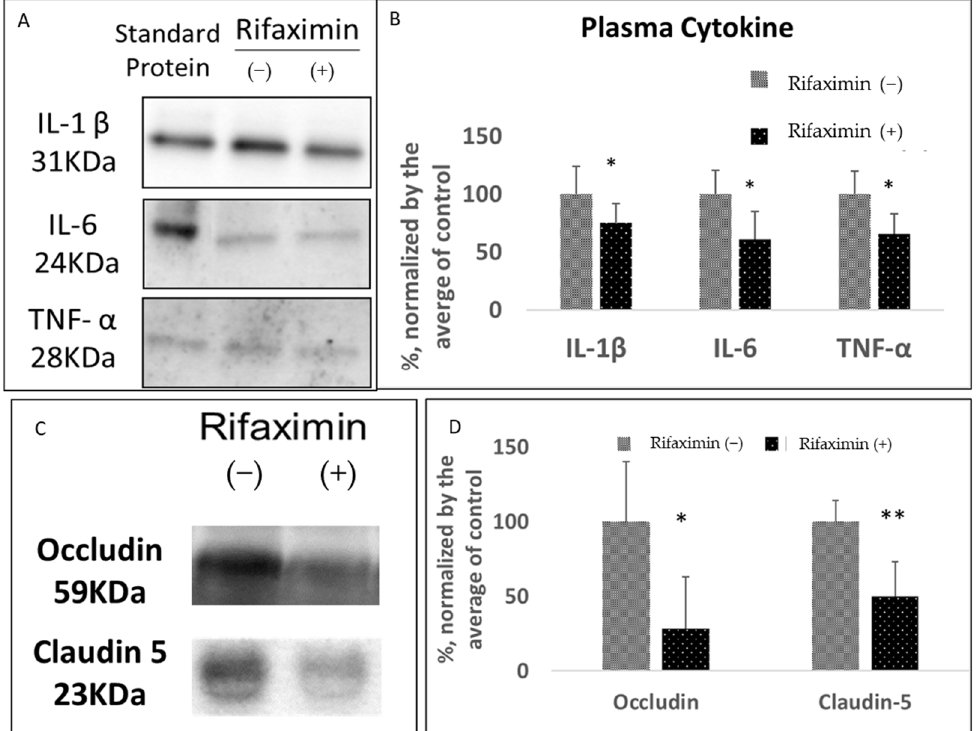
Figure 2. Effect of rifaximin treatment on the serum markers of inflammation and the blood–brain barrier in MitoPark mice. The serum samples of the MitoPark mice that were or were not treated with rifaximin for 3 months were obtained after the end of experiments before sacrifice. ( A , B ) The representative image and densitometry analysis results related to serum proinflammatory cytokines, namely IL-1 β , IL-6, and TNF- α , in the MitoPark mice that were or were not treated with rifaximin for 3 months. Standard IL-1 β (10 pg/mL), IL-6 (2 ng/mL), and TNF- α (0.5 ng/mL) were as the reference. ( C , D ) Representative image and densitometry analysis results related to the serum markers of blood–brain barrier permeabilization, namely claudin-5 and occludin, in the MitoPark mice that were or were not treated with rifaximin for 3 months. Data are presented as mean ± standard deviation. *, p < 0.05, **, p < 0.01.